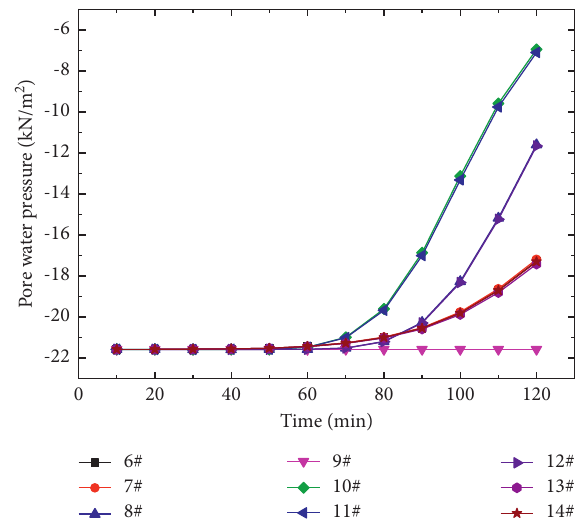
Figure 37: Pore water pressure of observation points 6–14 with seepage wells placed around buildings 1–4 in the numerical